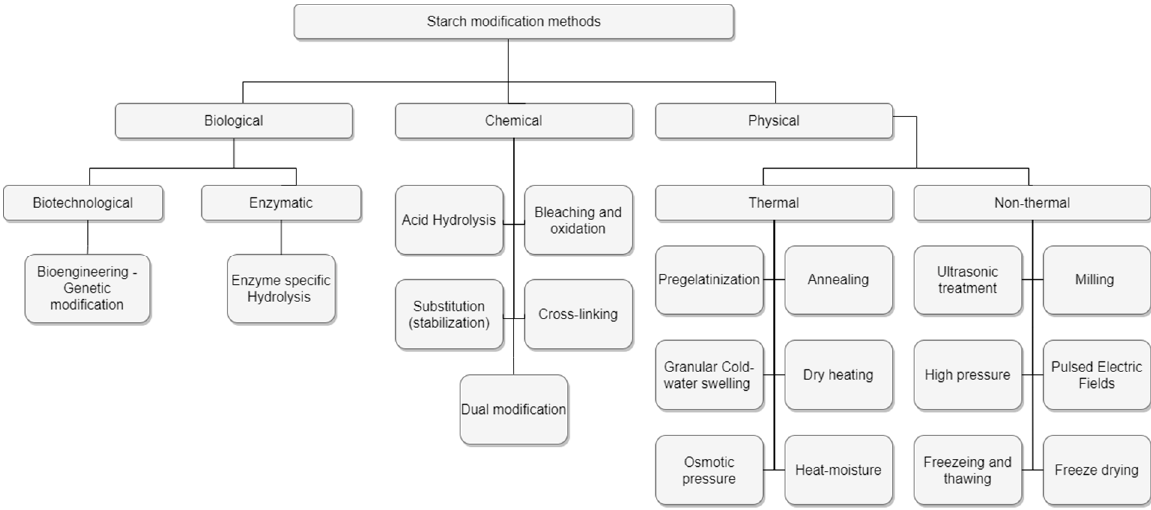
Figure 3. Modification methods for starch. Based on the methods of starch modification reported by [45].